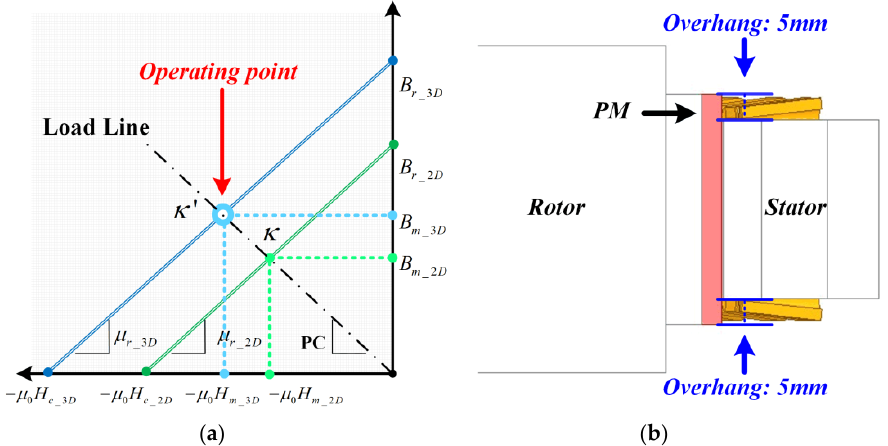
Figure 3. Operating point conversion through magnetic energy compensation of PMSM with over- hang structure: ( a ) operating point of permanent magnet with overhang structure, ( b ) PMSM model with overhang structure.